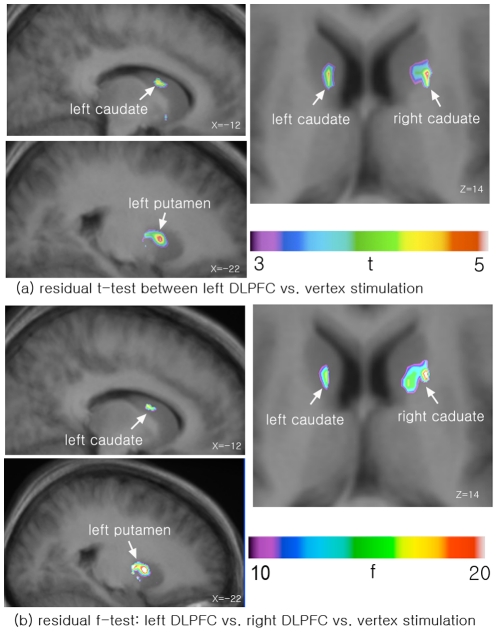
The similar results of t-test and f-test on real data.(a) t-test between left DLPFC stimulation vs. vertex stimulation (control condition): The t-map is overlaid upon the averaged MRI of all subjects in standard MNI space (published with permission from Ko et al. [9]). (b) f-test of all three stimulation condition (left DLPFC, right DLPFC and vertex stimulation): As the right DLPFC stimulation had no significant effect on BP in these regions, the f-map shows the similar pattern of t-map of left DLPFC vs. vertex stimulation.